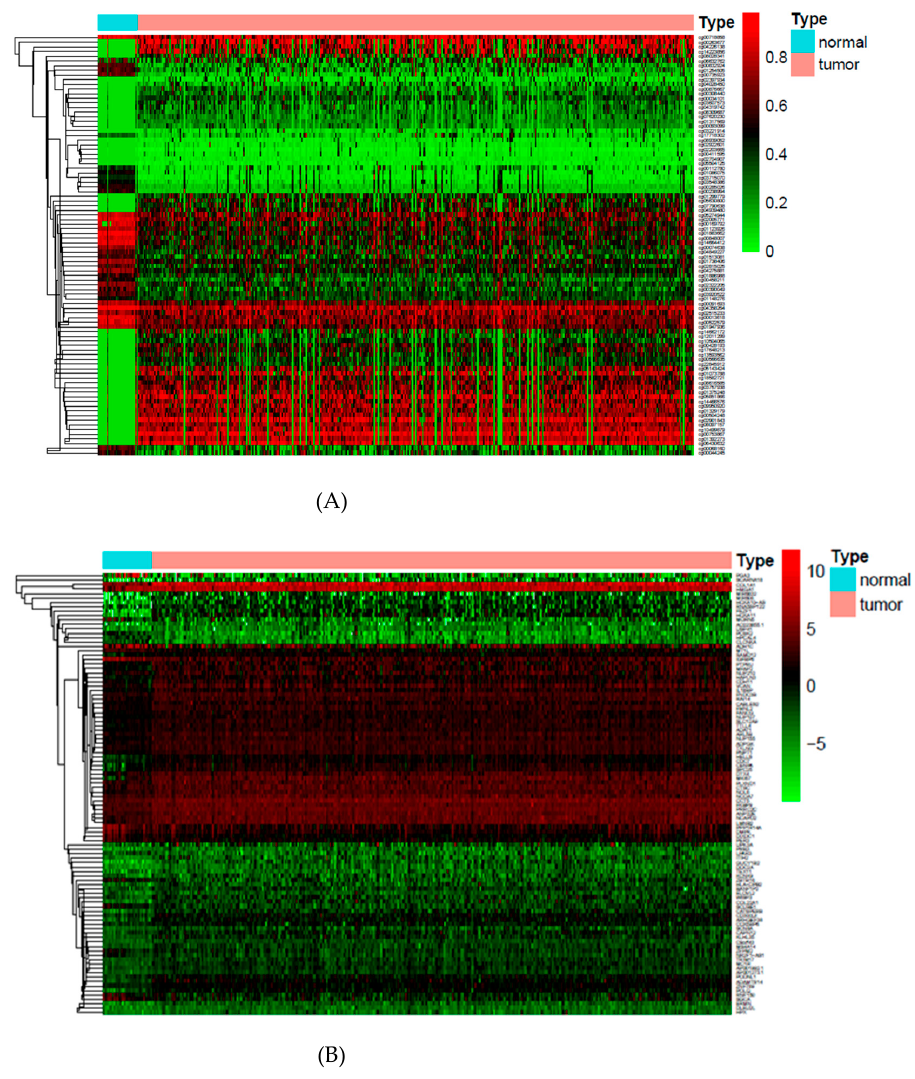
Figure 3. ( A ) The methylation levels of the top 100 methylation sites based on abs(B); ( B ) the gene expression levels of genes corresponding to these methylation sites.